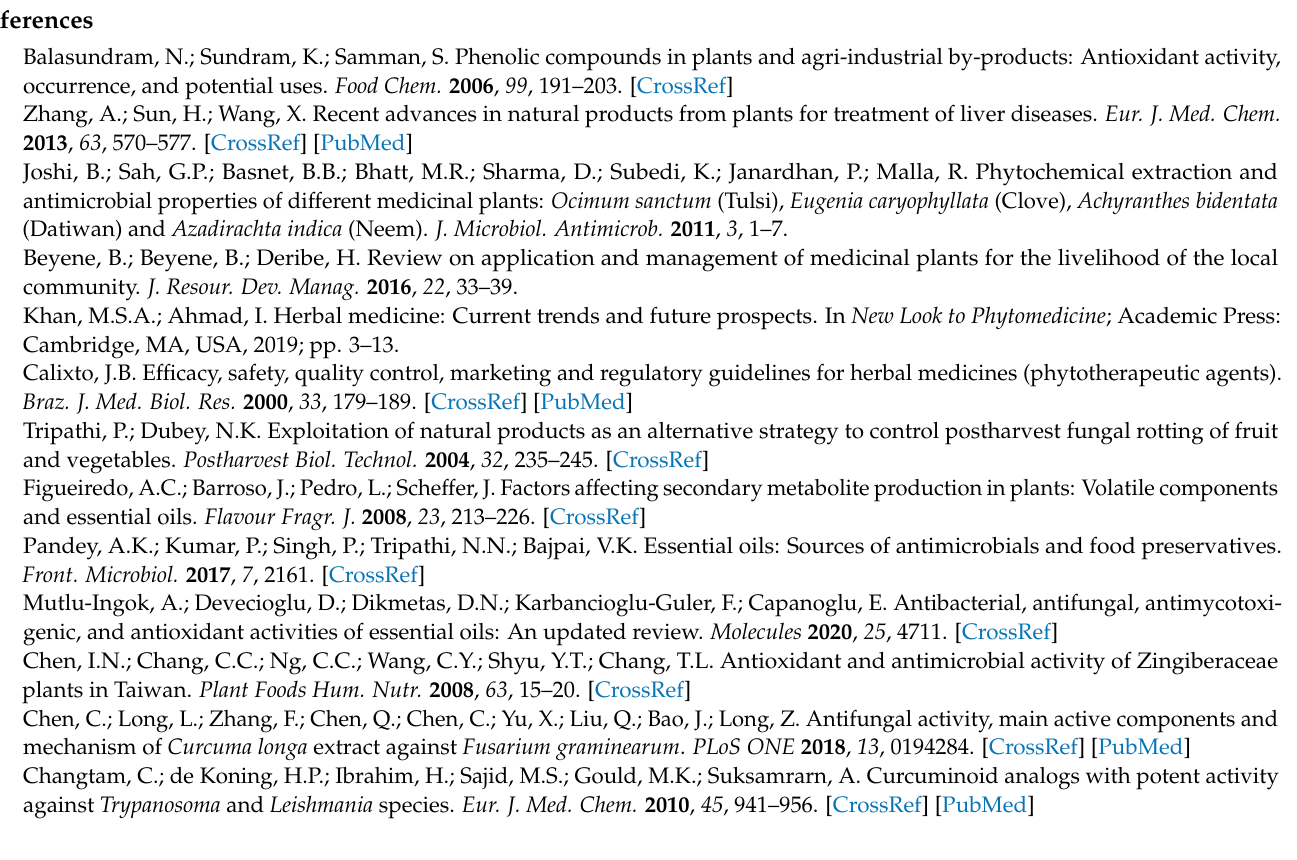
Figure S2: 3-D structure of major phytocompounds identified in the GC–MS analysis of CLO selected for docking. Figure S3: Target proteins selected as receptors for docking of phytocompounds of